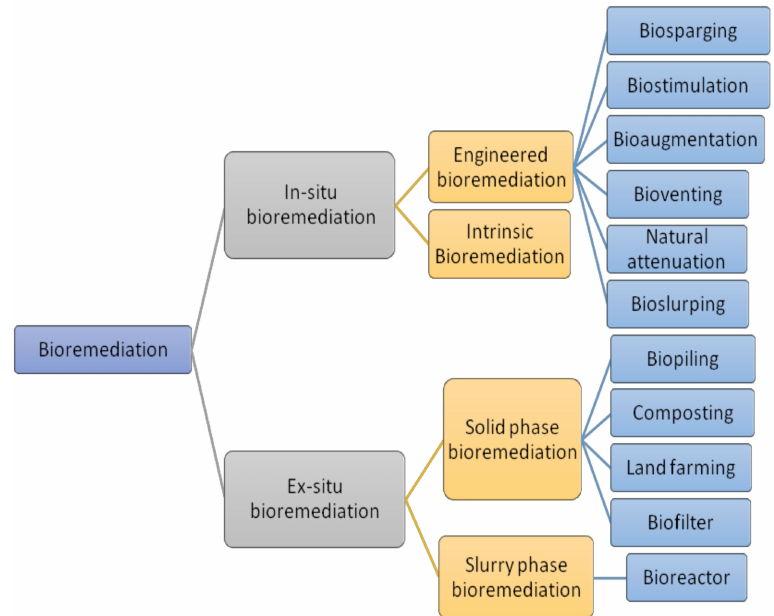
Figure 1. Diverse bioremediation